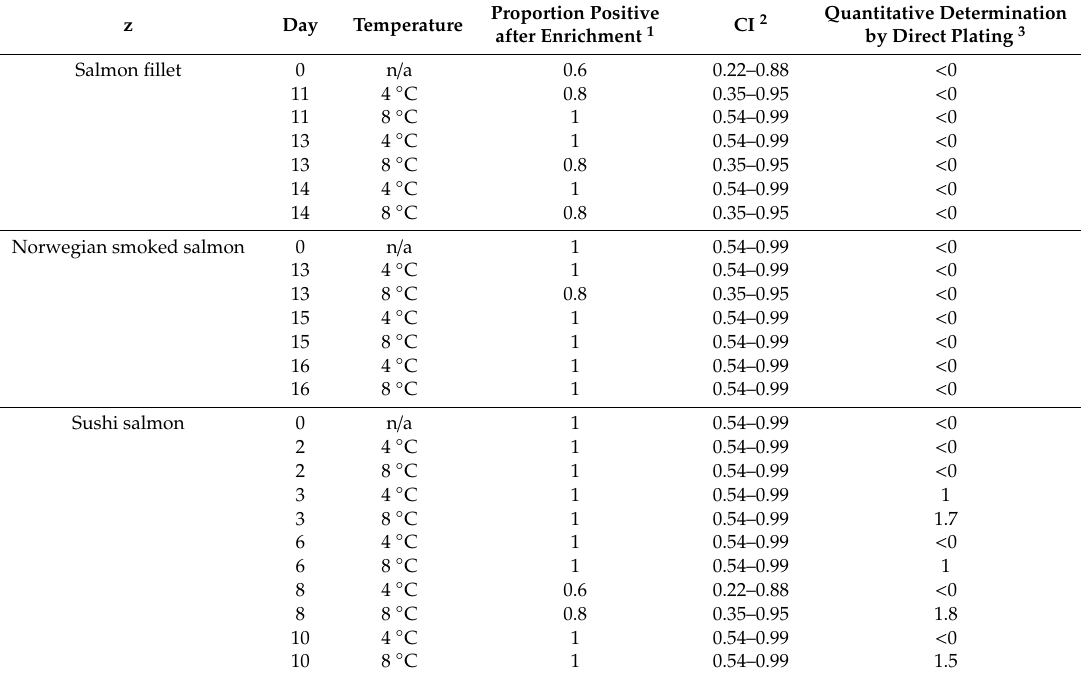
Table 4. Durability study with L. monocytogenes on di ff erent salmon products.